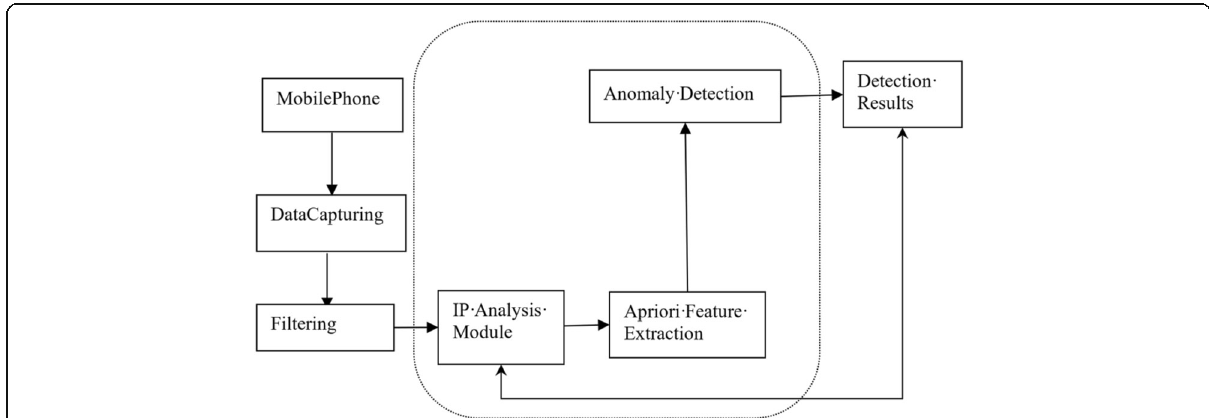
Fig. 1 ADMDM architecture. As shown in this figure, ADMDM firstly captures network traffic data, then performs IP linkage analysis on the weighted labels and uses Apriori algorithm for feature mining, and lastly, uses local outlier factor clustering algorithm to generate detection model